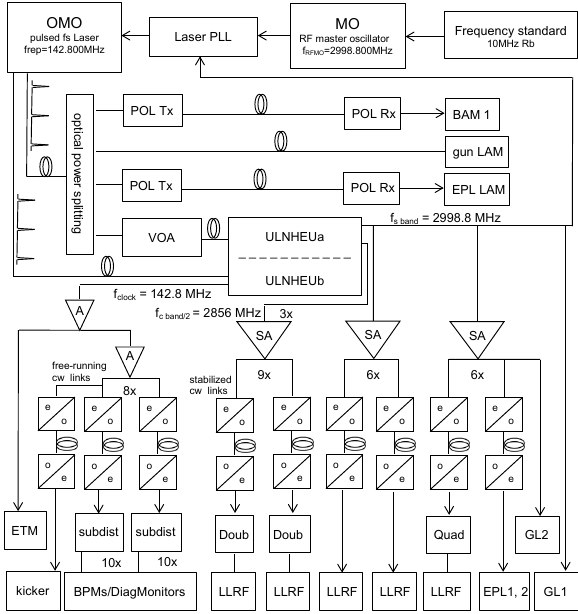
Figure 23. Schematic overview of the reference timing generation and distribution system in its current state. Only active elements are shown. OMO: Optical Master Oscillator, MO: Master Oscillator, PLL: Phase-locked loop, POL Tx/Rx: Pulsed Optical Link Transmitter/Receiver, BAM: Bunch Arrival Monitor, LAM: Laser Arrival Monitor, VOA: Variable Optical Attenuator (with power stabilization feedback), ULNHEU: Ultra-Low Noise Harmonic Extraction Unit, A: Amplifier, SA: Stabilized Amplifier, ETM: Event Timing Master, subdist: coaxial sub-distribution, BPM: Beam Position Monitor, DiagMonitors: various Diagnostic Monitors, Doub: Stabilized Frequency Doubler, LLRF: Low-Level RF, Quad: Stabilized Frequency Quadrupler, GL1: Gun Laser 1, GL2: Gun Laser 2, EPL1,2: Experiment Laser 1,2. Details are described in the